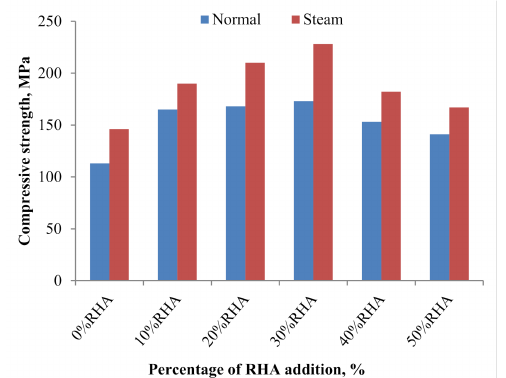
Figure 10. Concrete compressive strength with different levels of RHA replacement